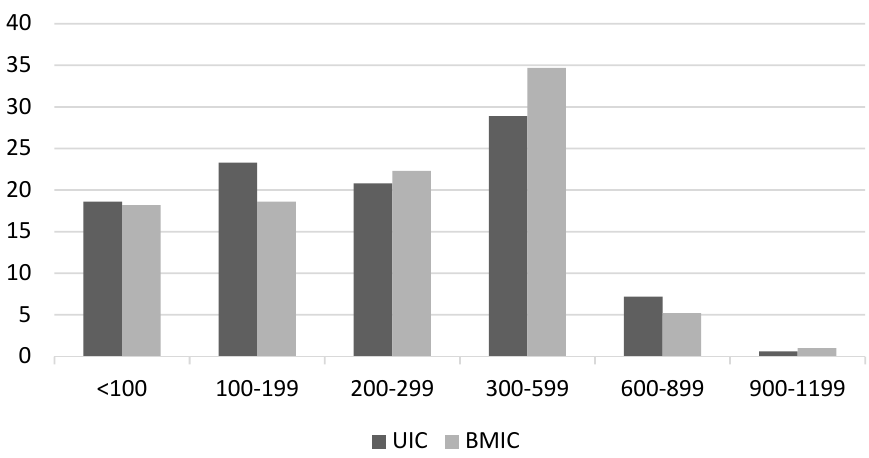
Figure 1. Percentage distribution of median urinary iodine concentration and breastmilk iodine concentration ( μ g/L).